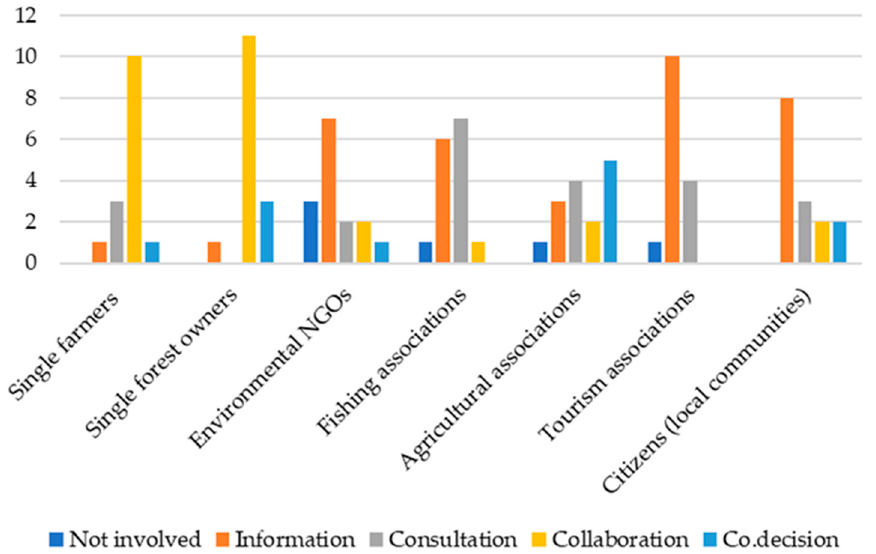
Figure 3. The level of importance of other stakeholders in PWS design (Q3).